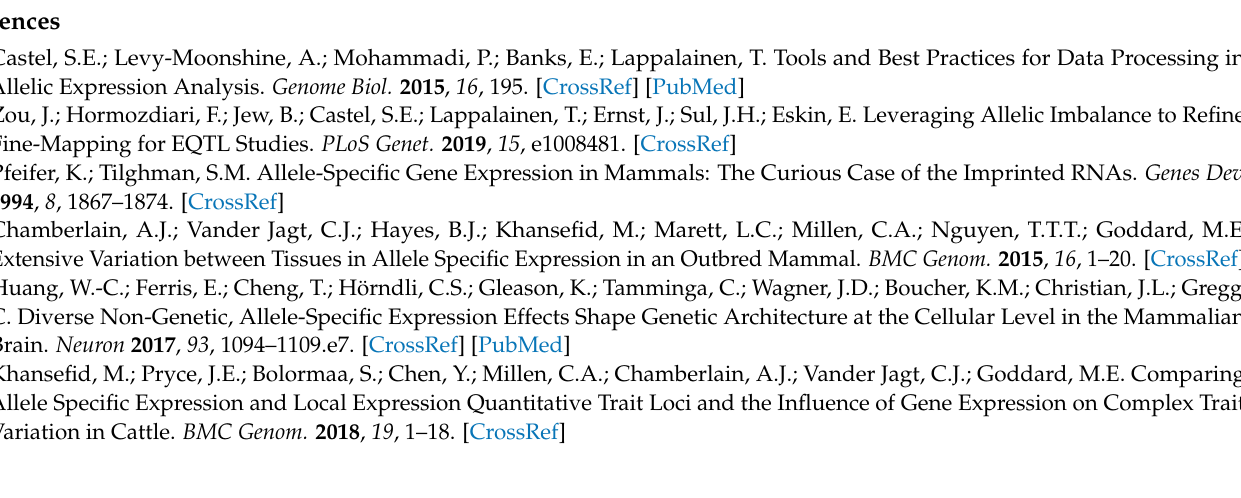
(GEBVs) of the contrasting samples. Table S2: Correlation of the phenotypes based on sample GEBVs. Table S3: Number of samples tested for Differential Allele-Specific Expression (DASE) Analysis. Table S4: Results of DASE analysis. Table S5: Gene Ontology (GO) enrichment based on molecular functions and biological processes. Table S6: Enrichment of DASE genes based on KEGG pathways. Table S7: Co-expression results based on DASE genes pairs. Table S8: Over-representation analysis (ORA) of biological processes involved with DASE genes. Table S9: Gene set enrichment analysis (GSEA) for WBSF0 phenotype; Table S10: Data integration results. Table S11: Overlapping SNPs based on integration analysis. Supplementary Data S1: Plots of permutation tests implemented by using regioneR